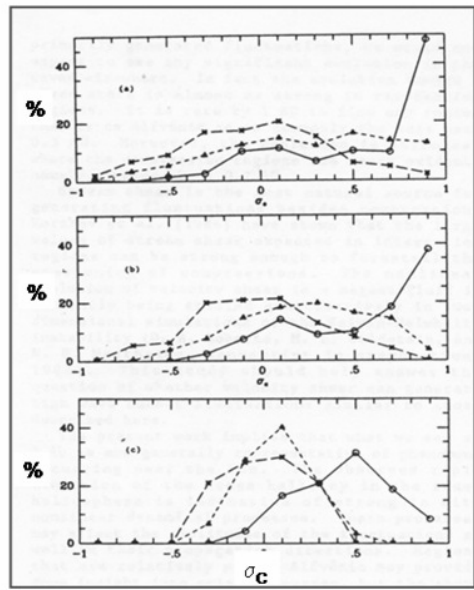
Figure 38: Histograms of normalized cross-helicity 𝜎 c showing its evolution between 0.3 (circles), 2 (triangles), and 20 (squares) AU for different time scales: 3 h (top panel), 9 h (middle panel), and 81 h (bottom panel). Image reproduced by permission from Roberts et al. (1987b), copyright by AGU.